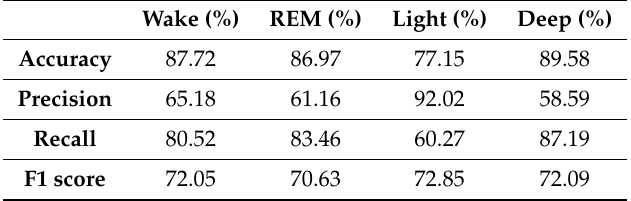
Figure 6. Estimated and true Hypnograms of the Sleep-EDFx public data set (SC4031E0). Table 1. Accuracy, precision, and recall for all four sleep stages, yielded by the HMM algorithm for the Sleep-EDFx public data set with 61 participants consisting of 63,231